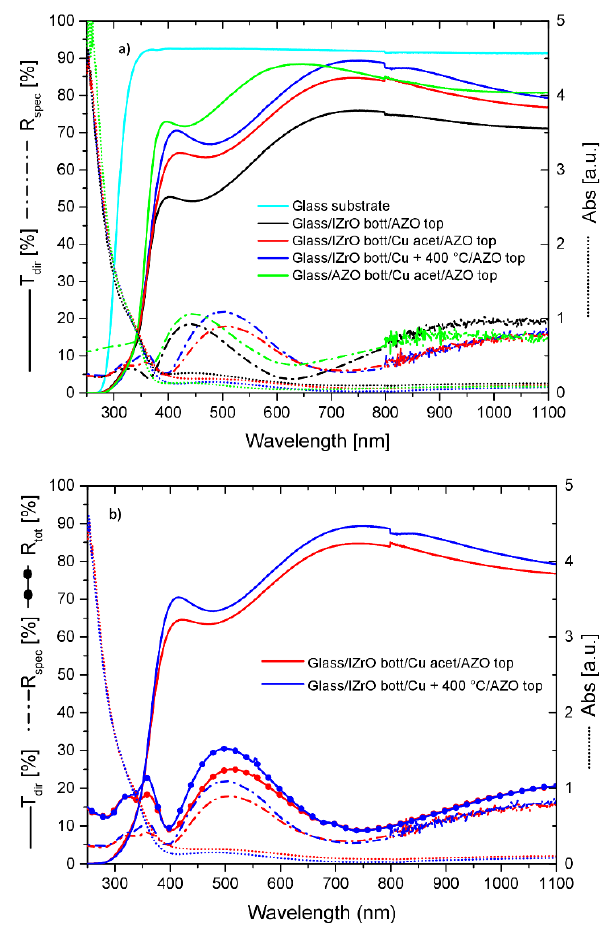
Figure 6. ( a ) Comparison of direct transmission, specular reflectance, and absorbance of the best selected structures. Glass substrate and Glass/IZrO bott /AZO top are reported as reference points. ( b ) Comparison of direct transmission, total reflectance, and absorbance of wet (Glass/IZrO/Cu Acet/AZO) and dry (Glass/IZrO/ Cu + 400 °C/AZO) structures.